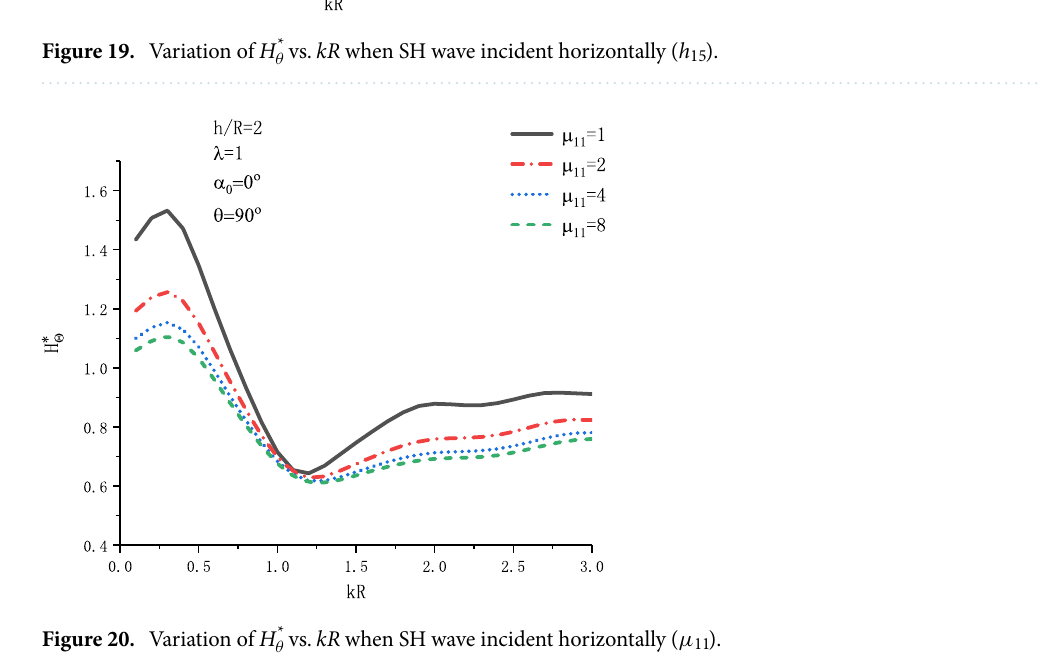
Figure 20. Variation of H